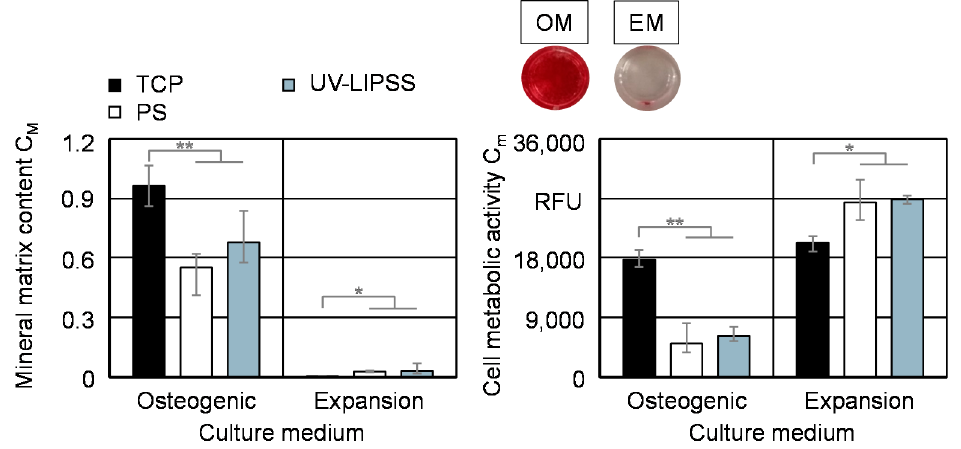
Figure 10. Cell mineral matrix content C m on TCP, PO, and UV-LIPSS after culture time t c = 16 days. Statistical analysis by ANOVA and Tukey’s test for the determination of statistically significant differences (n = 5 each group, * for p < 0.05, ** for p < 0.01).